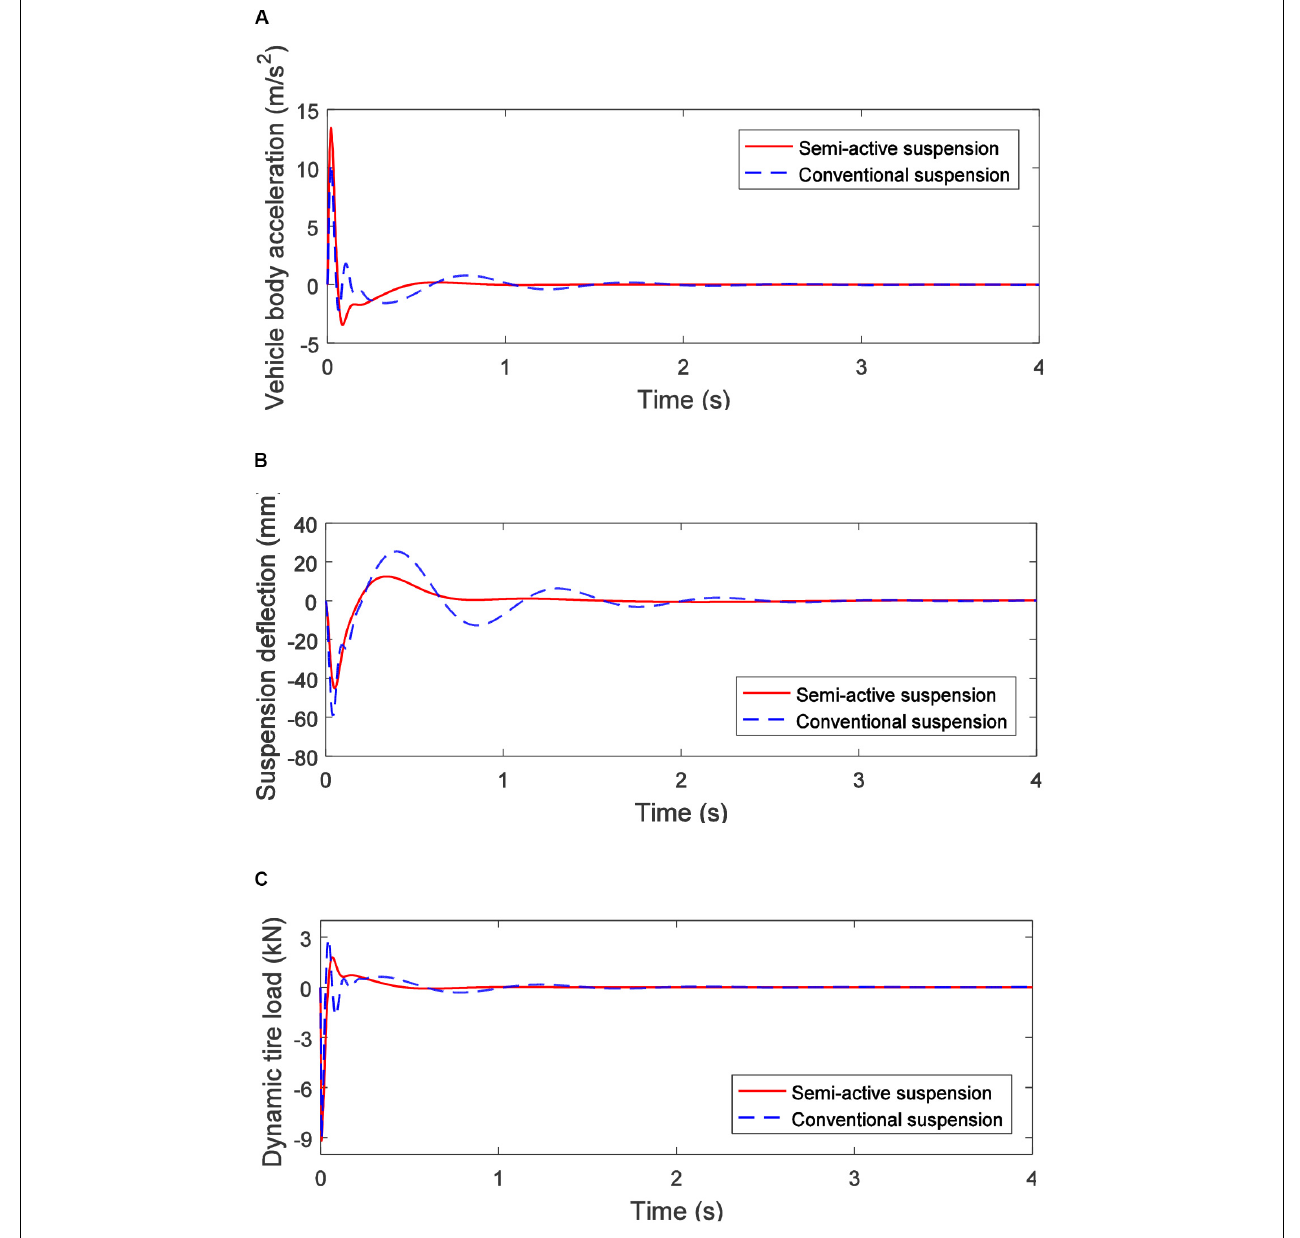
FIGURE 15 | Unit impulse response of the 1/4 vehicle suspension: (A) vehicle body acceleration, (B) suspension deflection, and (C) dynamic tire